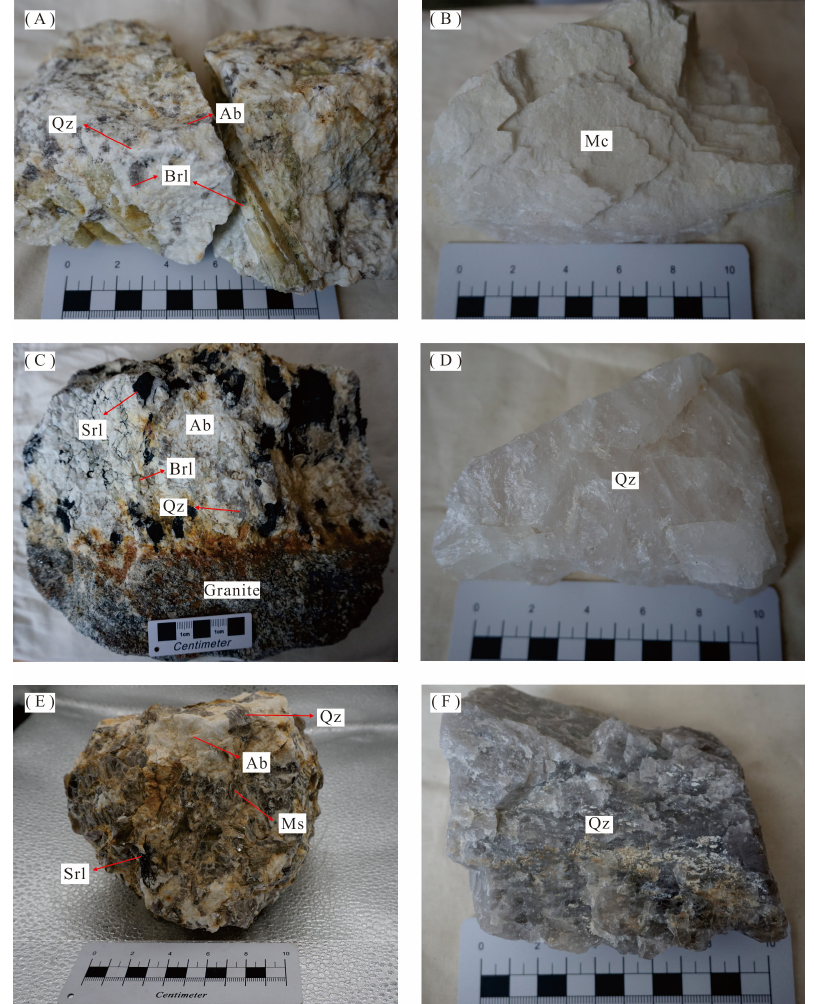
Figure 4. Photographs of ores from the Dakalasu No. 1 pegmatite vein. ( A ) Graphic texture zone; ( B ) Block microcline feldspar; ( C ) Contact zone between biotite granite and graphic texture pegmatite; ( D ) Rose quartz from the transitional zone; ( E ) Quartz—muscovite zone; ( F ) Quartz from the quartz core. Quartz = Qz; Albite = Ab; Microcline = Mc; Schorl = Srl; Beryl = Brl; Muscovite = Ms.